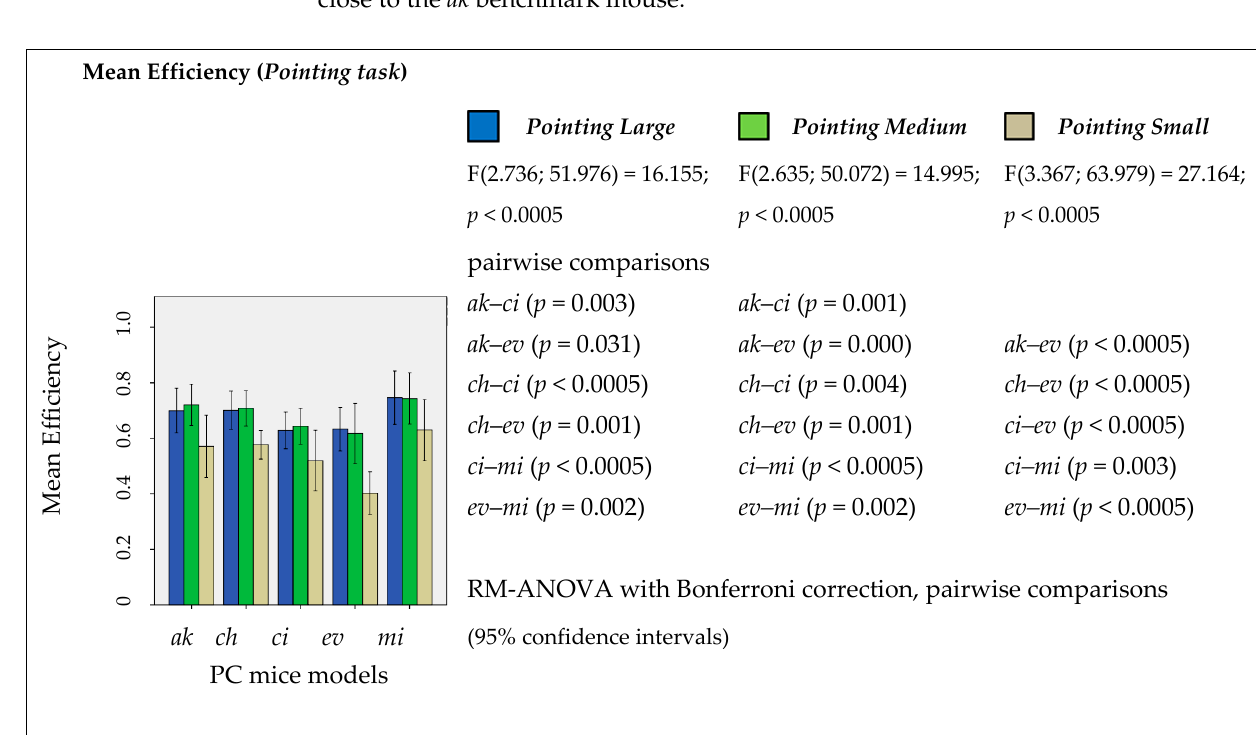
Figure 11. Mean efficiency by task evaluated between mice geometries with RM-ANOVA with a Bonferroni correction applied to pairwise comparisons.